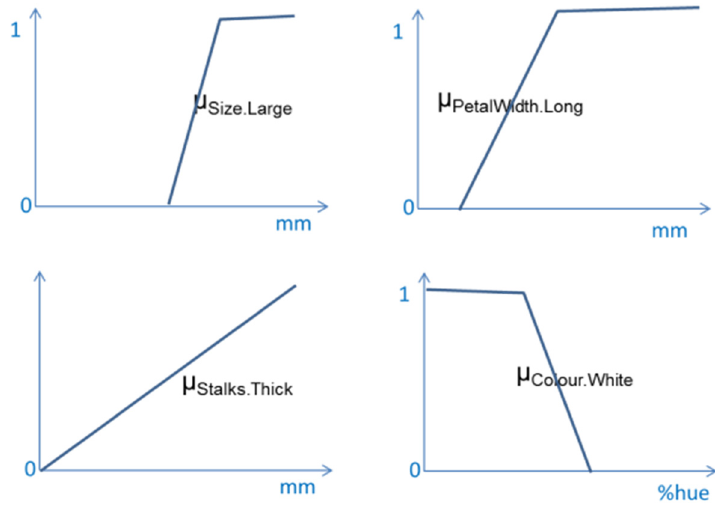
Figure 6. Membership functions of the fuzzy sets Size.large , PetalWidth.Long , Stalks.Thick , and Colour.White .